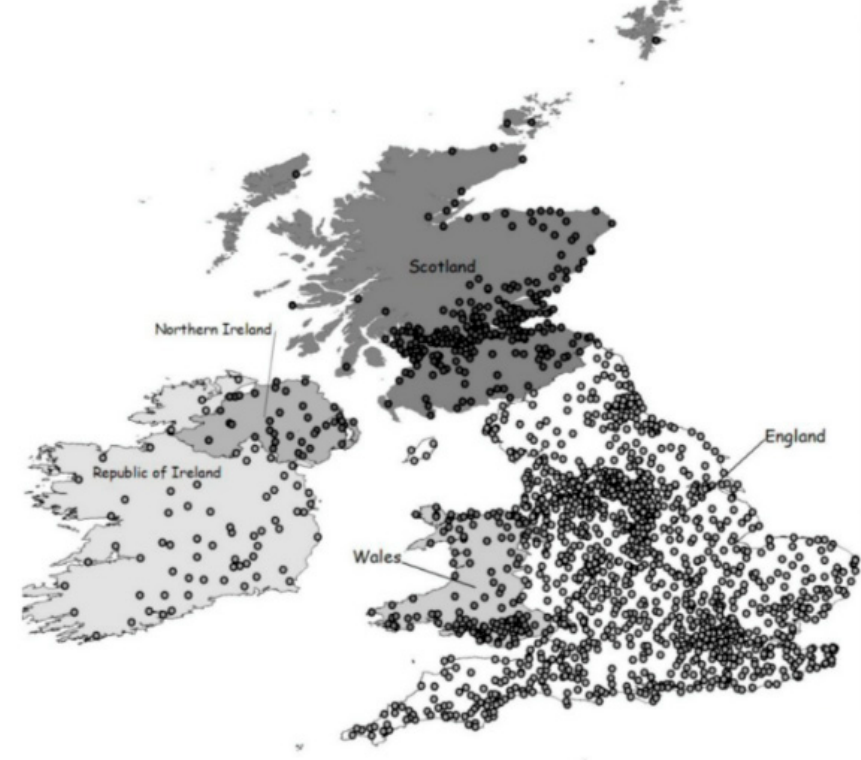
Figure 3. Known and suspected locations of manufactured gas sites in the British Isles [55].